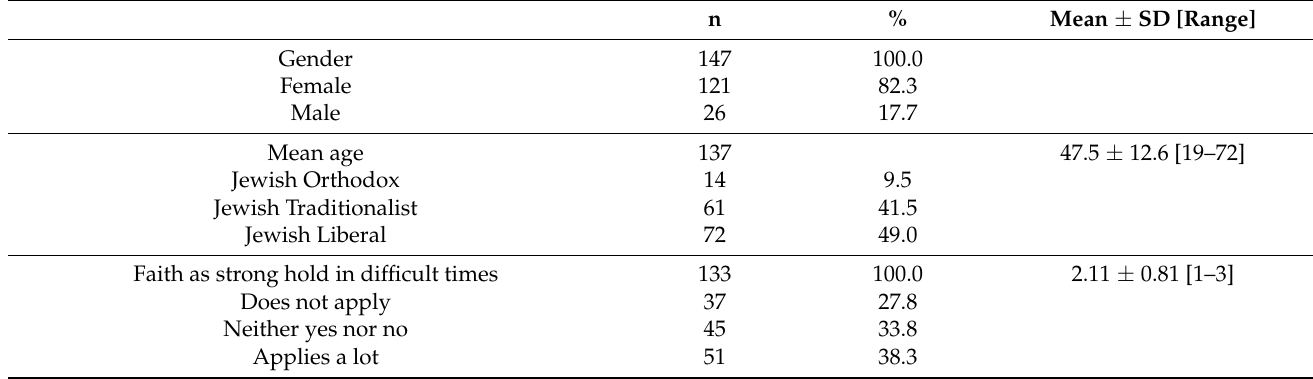
Table 1. Description of the sample (n =